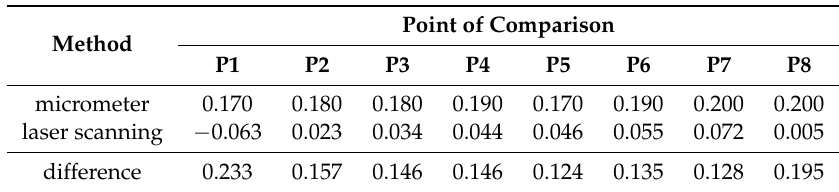
Figure 7. Two point clouds of the same grapevine leaf colorized with the calculated thickness values. Table 4. Comparison of the invasive measured leaf thickness and the laser scanning result for grape vine leaf shown in Figure 7 (left). Units: